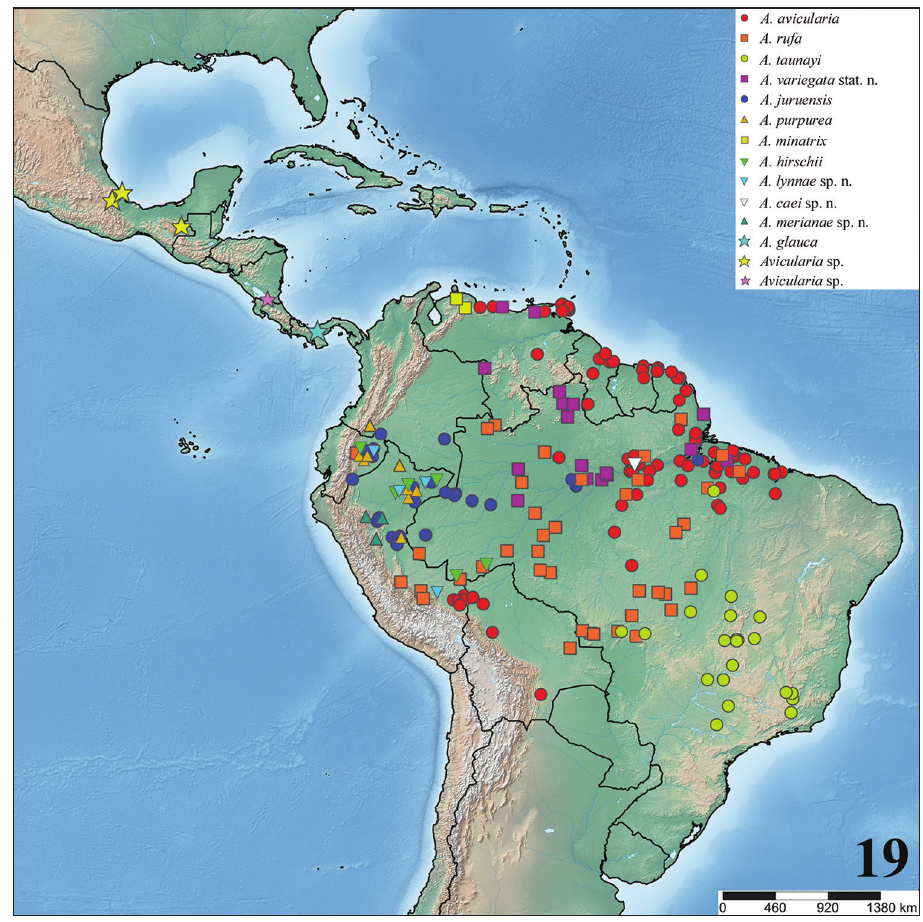
Figure 19. Map showing records of Avicularia Lamarck, 1818 species in Central and South